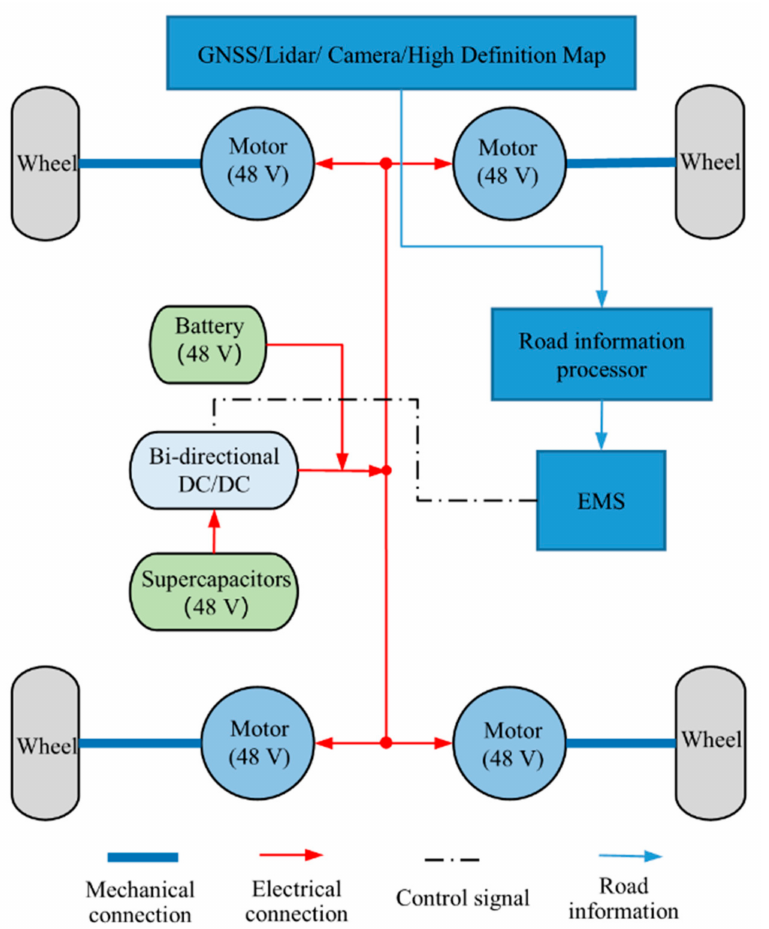
Figure 1. Hybrid power system